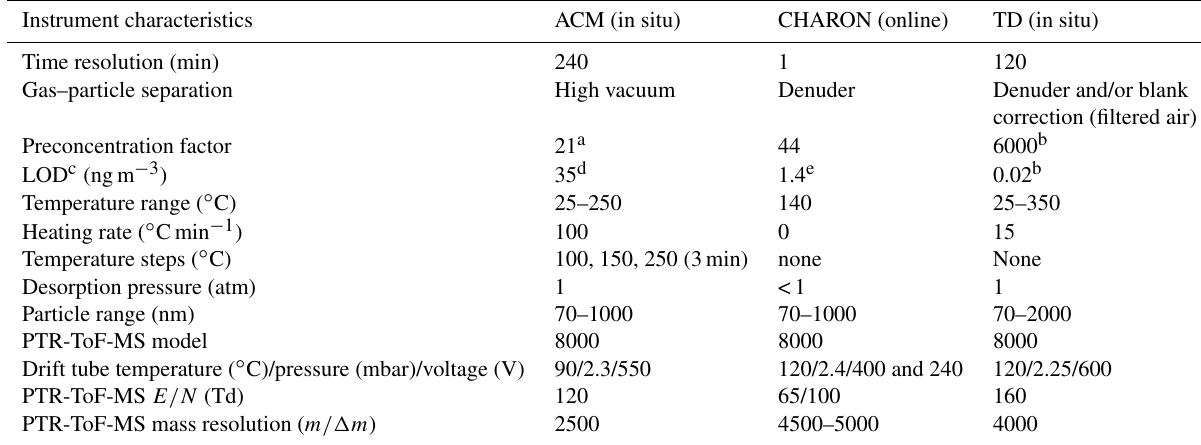
Table 2. Instruments operating